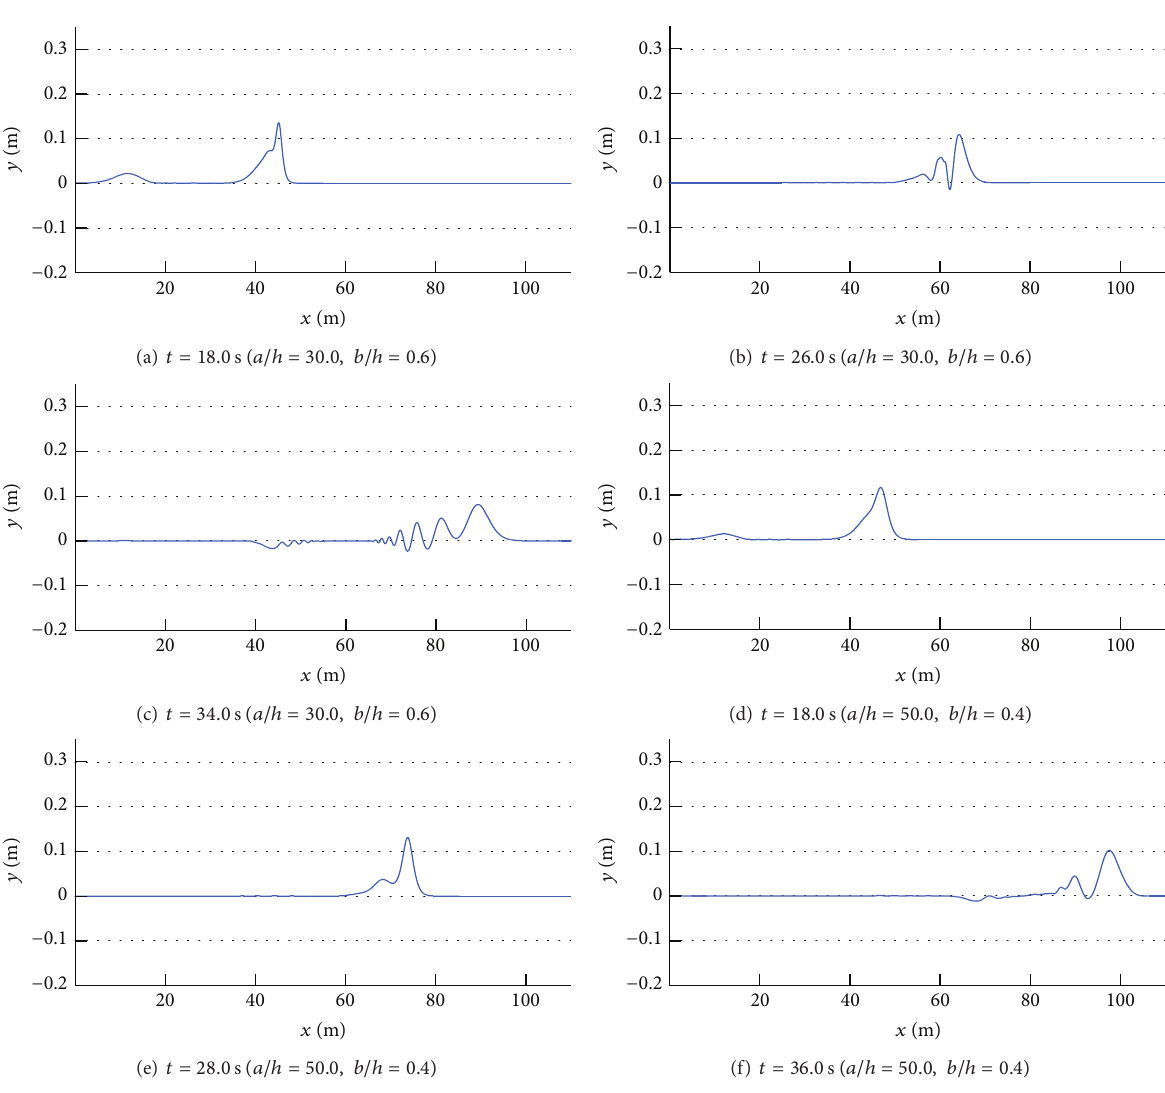
Figure 7: Fission process triggered by a submerged